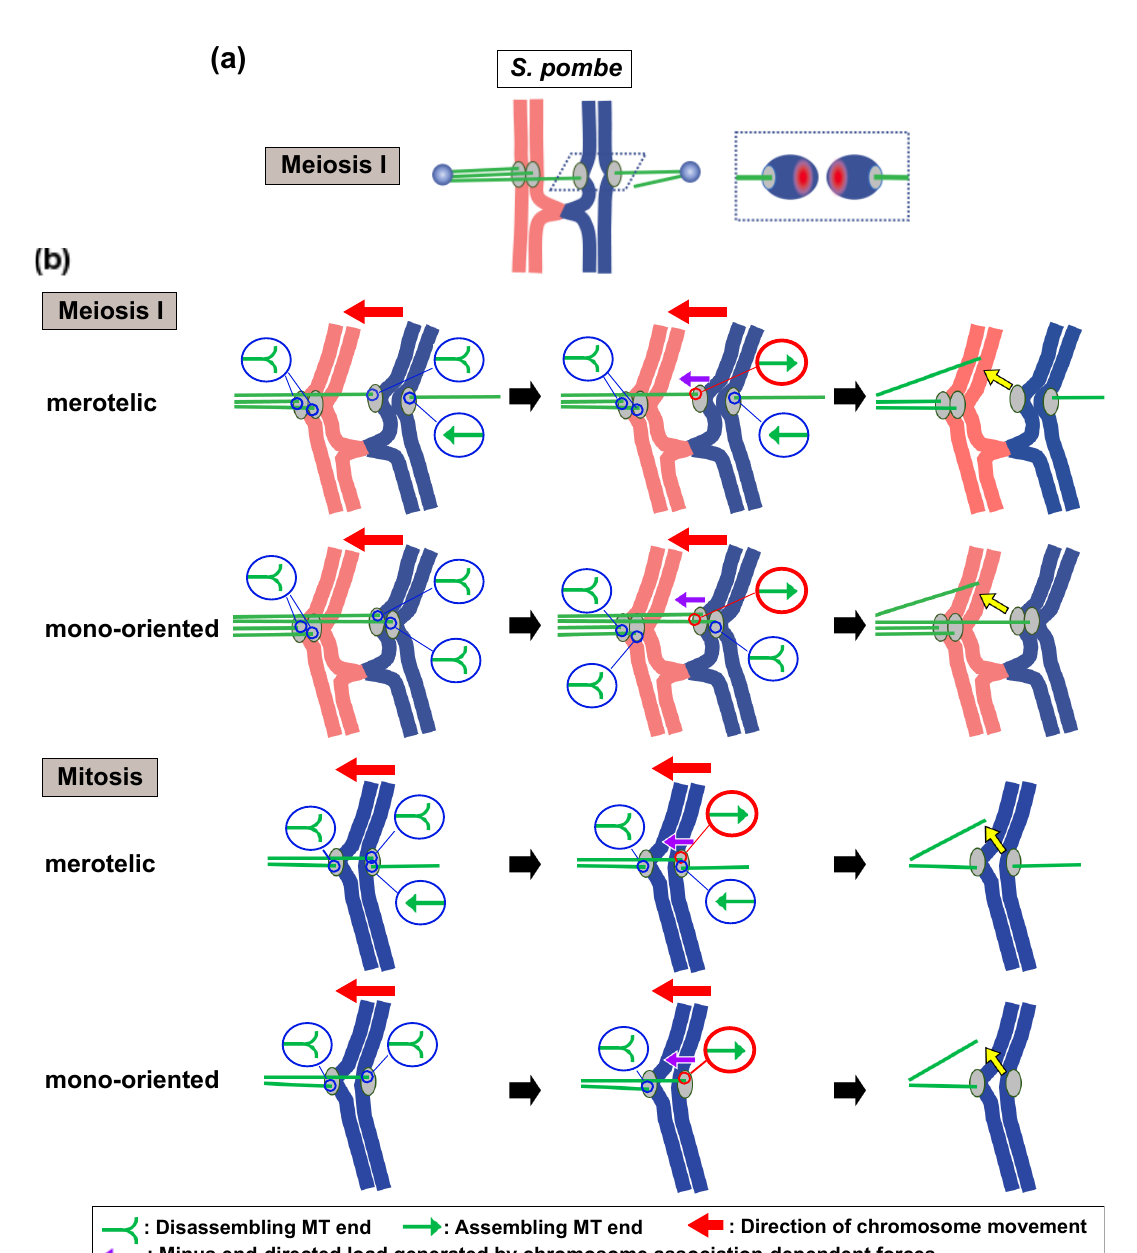
Figure 4. A problem with the tension-dependent spatial separation model and attachment elimination by chromosome oscillation. ( a ) A problem with the tension-dependent spatial separation model at meiosis I in fission yeast. Because sister centromeres separate from each other after their bi-oriented attachment, orientation of kinetochores/centromeres easily changes. Consequently, erroneous attachment sites do not approach the Aurora B–enriched region, preventing the phosphorylation of kinetochore components by Aurora B. ( b ) The model for oscillation-dependent elimination of improper attachments at meiosis I (meiosis I) and in mitosis (mitosis). During poleward movements of erroneously attached chromosomes, kMTs extending forward shorten, whereas those extending rearward elongate. Unsynchronized switching of assembly/disassembly dynamics of kMTs generates occasions, in which chromosome association-dependent pulling (purple arrows) exerts a minus end-directed load on assembling kMT ends (red circles), leading to kMT detachment. Such situation cannot occur at proper attachment sites (see Figure 3b). Meiosis I/merotelic: simultaneous bi-oriented attachments of one sister chromatid pair and homologous chromosomes; meiosis I/mono-oriented: mono-oriented attachment of homologous chromosomes; mitosis/merotelic: simultaneous bi-oriented attachments of a single chromatid and both sister chromatids; mitosis/mono-oriented: mono-oriented attachment of both sister chromatids. Circles indicate the assembly/disassembly states of kMT ends. For simplicity, only one kMT attached to each single kinetochore is